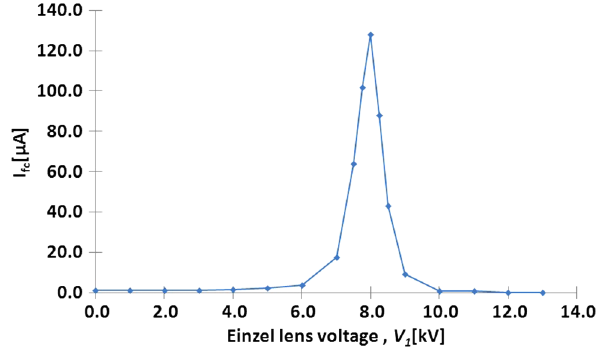
FIG. 10. Dependence of the beam current of He 1 þ ions on V 1 as measured with a Faraday